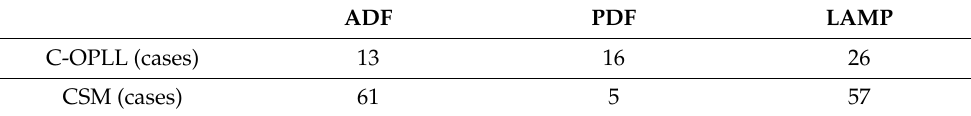
Table 3. Operative